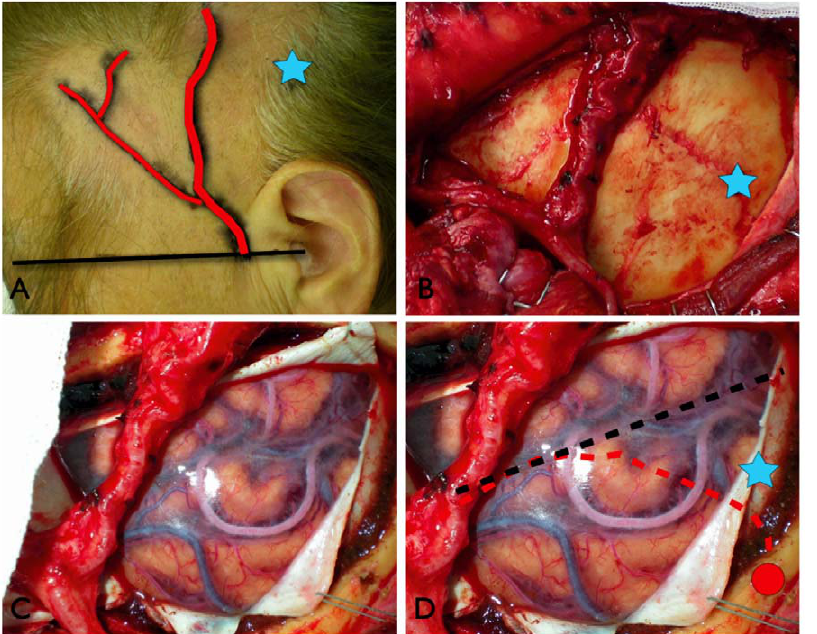
Figure 6. Clinical application of Squamous suture landmark in a representative case. a) Skin marking of the OM line (black line), the donor artery (STA, red line) and Chater’s Point (CP, blue star). b) Bone marking using SS as the center of the craniotomy, the adjacent STA is also visible; blue star is showing the CP. c) The clearly viewed SF with its correlated arties and veins at the center of the operative field after craniotomy. d) Illustration of the running SS (dotted red line), SF (dotted black line), CP (blue star) and start point of SS at 0 cm perpendicular to OM line (red circle).